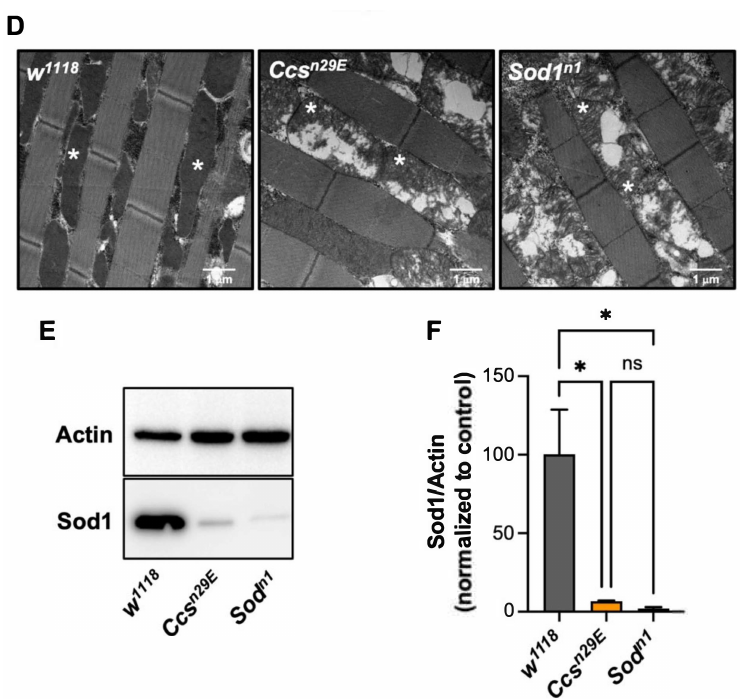
Figure 1. Ccs n29E null flies show milder phenotypes than Sod1 n1 mutants: ( A ) Survival analysis. Ccs n29E mutants lived significantly less than w 1118 controls but longer than Sod1 n1 flies (Mantel–Cox log-rank test: w 1118 vs. Ccs n29E (****), w 1118 vs. Sod1 n1 (****), Ccs n29E vs. Sod1 n1 (####), p < 0.0001 for all comparisons. N: 162 Ccs n29E , 288 Sod1 n1 , and 260 w 1118 ); ( B ) climbing activity (mean ± SEM). Analysis of variance and post-hoc tests indicate significant locomotor impairments in Ccs n29E and Sod1 n1 flies as compared with w 1118 controls, with Sod1 n1 mutants showing the strongest phenotype (one-way ANOVA F 2, 516 = 123.7 p < 0.0001; Tukey’s multiple comparisons test: w 1118 vs. Ccs n29E (****) and w 1118 vs. Sod1 n1 (****), p < 0.001; Ccs n29E vs. Sod1 n1 (**), p = 0.0075. N: 178 Ccs n29E , 164 Sod1 n1 , and 177 w 1118 ); ( C ) survival analysis under mild oxidative stress conditions (1 mM paraquat). Ccs n29E flies were significantly more and less sensitive as compared with w 1118 and Sod1 n1 flies, respectively (Mantel–Cox log-rank test: w 1118 vs. Ccs n29E (****), w 1118 vs. Sod1 n1 (****), Ccs n29E vs. Sod1 n1 (####), p < 0.0001 for all comparisons. N: 172 Ccs n29E , 56 Sod1 n1 , and 99 w 1118 ); ( D ) representative TEM images of the mitochondrial morphology of Ccs n29E , Sod1 n1 mutants, and w 1118 controls. Asterisks in the pictures indicate representative mitochondria; ( E ) representative Western blot; ( F ) relative quantification of Sod1 levels (mean ± SEM) in Ccs n29E , Sod1 n1 , , and w 1118 flies; in ( F ), Sod1 levels are reported as the Sod1/Actin ratio, with Actin signal used as a loading control. Ccs n29E and Sod1 n1 flies showed a significantly lower Sod1 amount with respect to controls (one-way ANOVA: F 2, 6 = 11.51, p = 0.0088; Tukey’s multiple comparisons test: w 1118 vs. Ccs n29E (*) and w 1118 vs. Sod1 n1 (*) p <